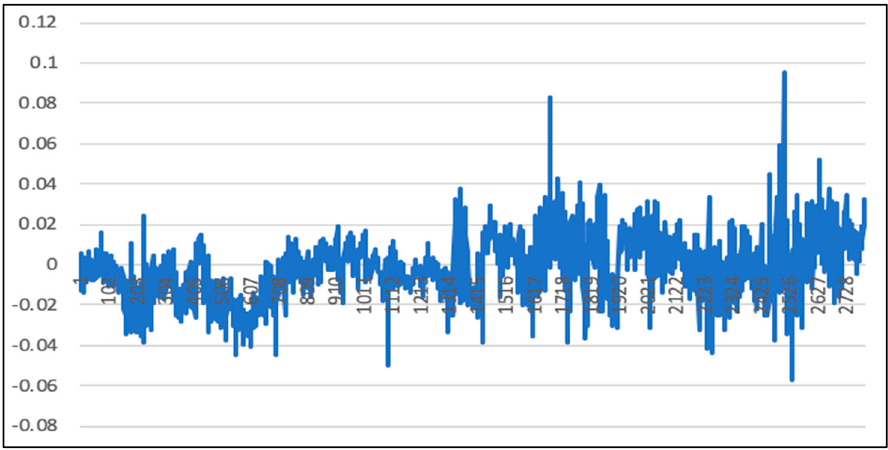
Figure 18. Error map of RF prediction results and actual results (8500th data to 11,300th data).